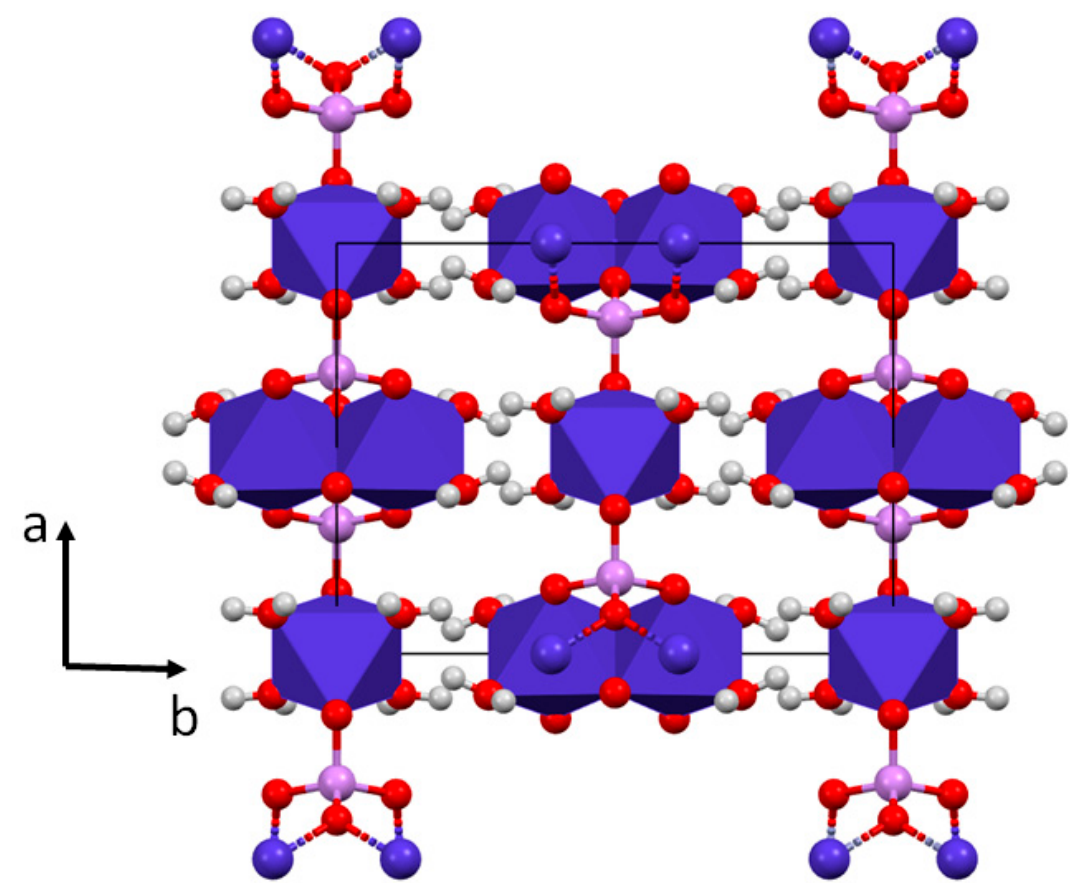
Figure 1. Crystal structure of arsenate-series vivianite-group minerals viewed along the c axis. Metals occupy insular and double-edged octahedra (blue). Red spheres—oxygen; violet spheres—arsenic; grey spheres—hydrogen.